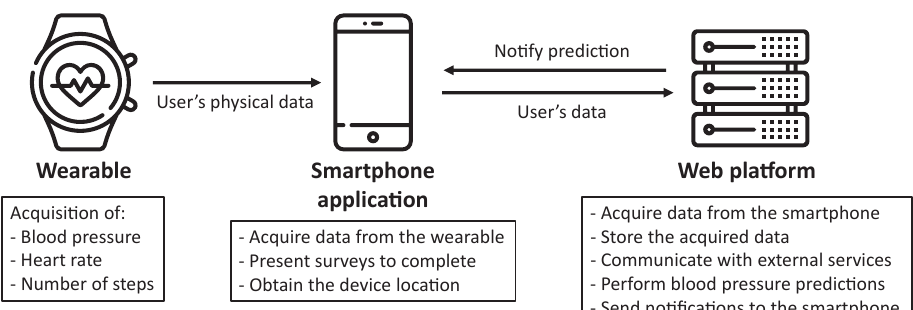
Figure 1. Main elements of the SENIOR web ecosystem.